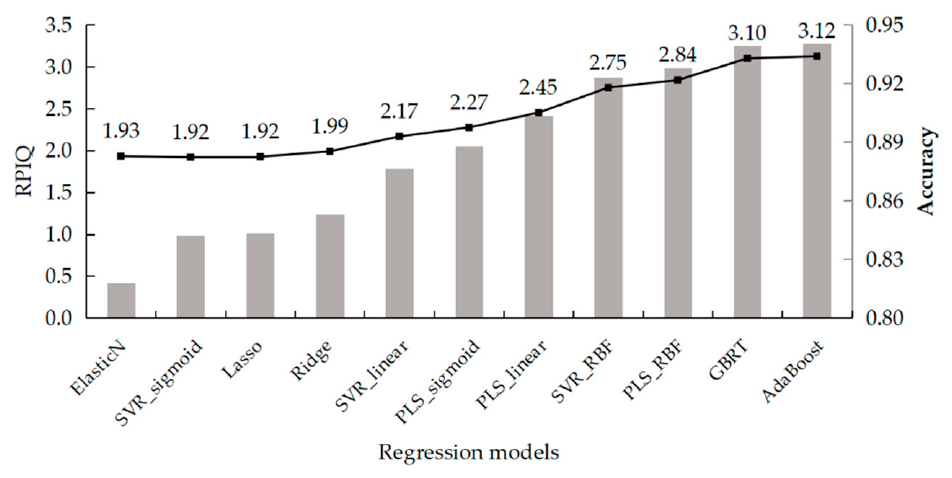
Figure 7. RPIQ and accuracy of the best regression models.